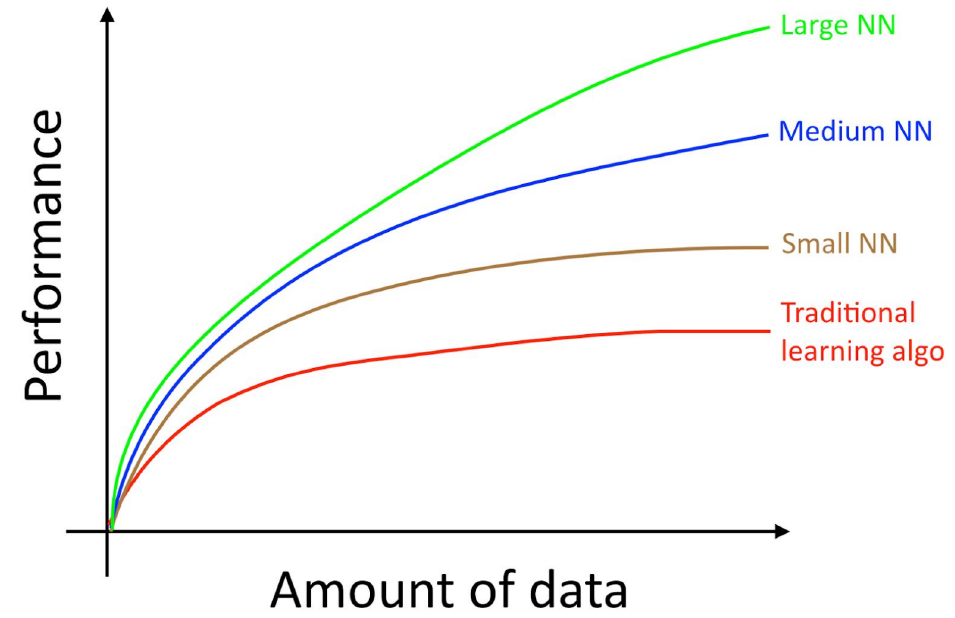
Figure 7. The relevance between the amount of data and the model’s performance